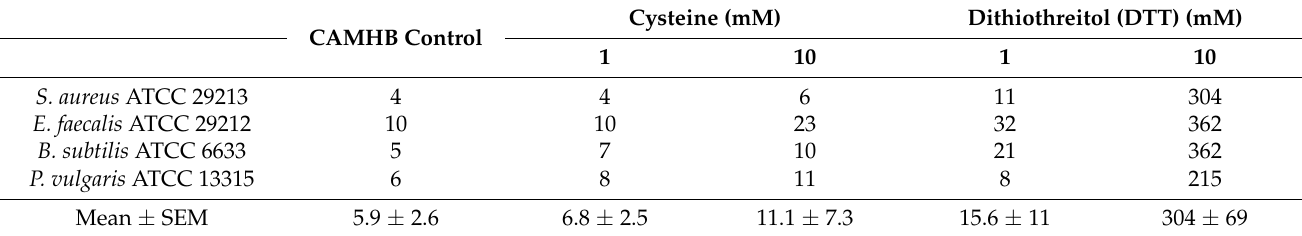
Table 2. Antibacterial activity a (mg/L) of NPBD in the presence of 1 and 10 molar excess of cysteine and dithiothreitol. Cysteine CAMHB Control